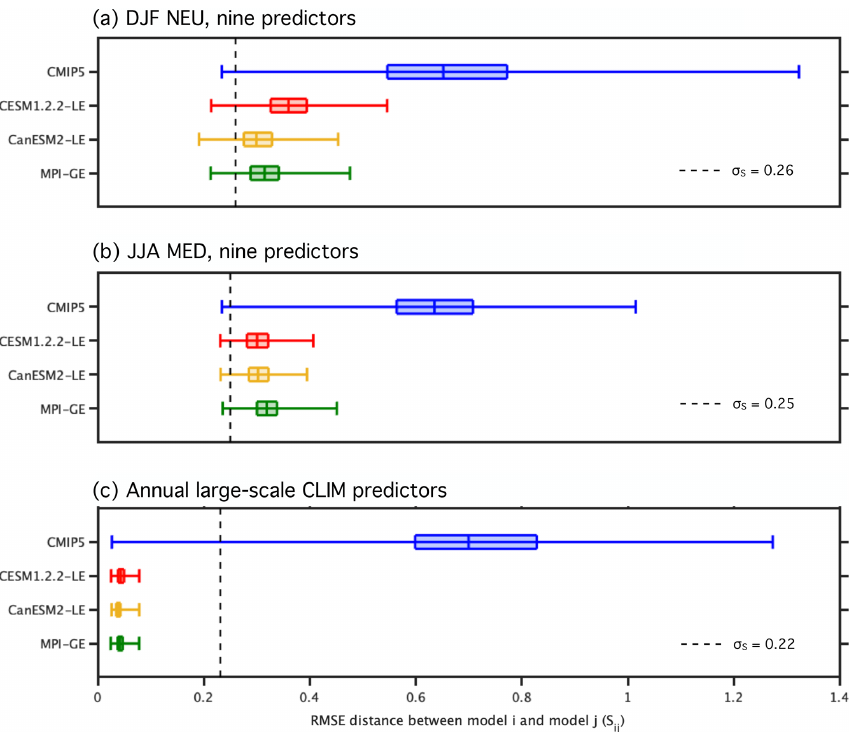
Figure B2. Distributions of RMSE distance ( S ij ) within the SMILEs, the CESM1.2.2-LE (red), the CanESM2-LE (yellow), the MPI-GE (green), and the CMIP5 ensemble (blue). The box element spans the 25th to 75th percentile of the distribution; the median S ij is indicated by the horizontal line within the box. The whisker element spans the full range of the S ij distribution. The value of σ S used for the weighting is indicated by the dashed line. DJF NEU distances based on the nine predictors are shown in (a) , JJA MED distances based on the nine predictors are shown in (b) , and distances based on annual global land SAT and Northern Hemisphere SLP climatology are shown in (c)